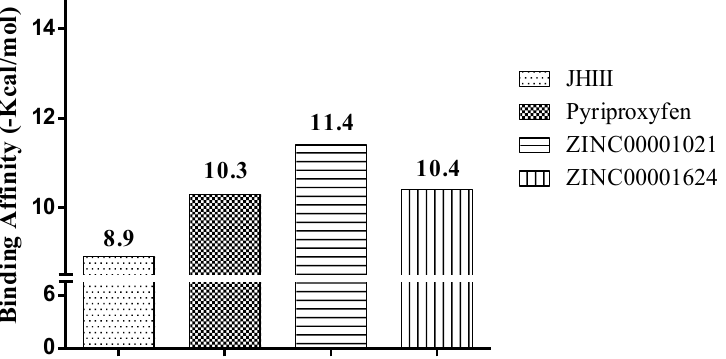
Figure 6. Results of binding affinity of the compounds with the juvenile hormone (PDB ID 5V13).